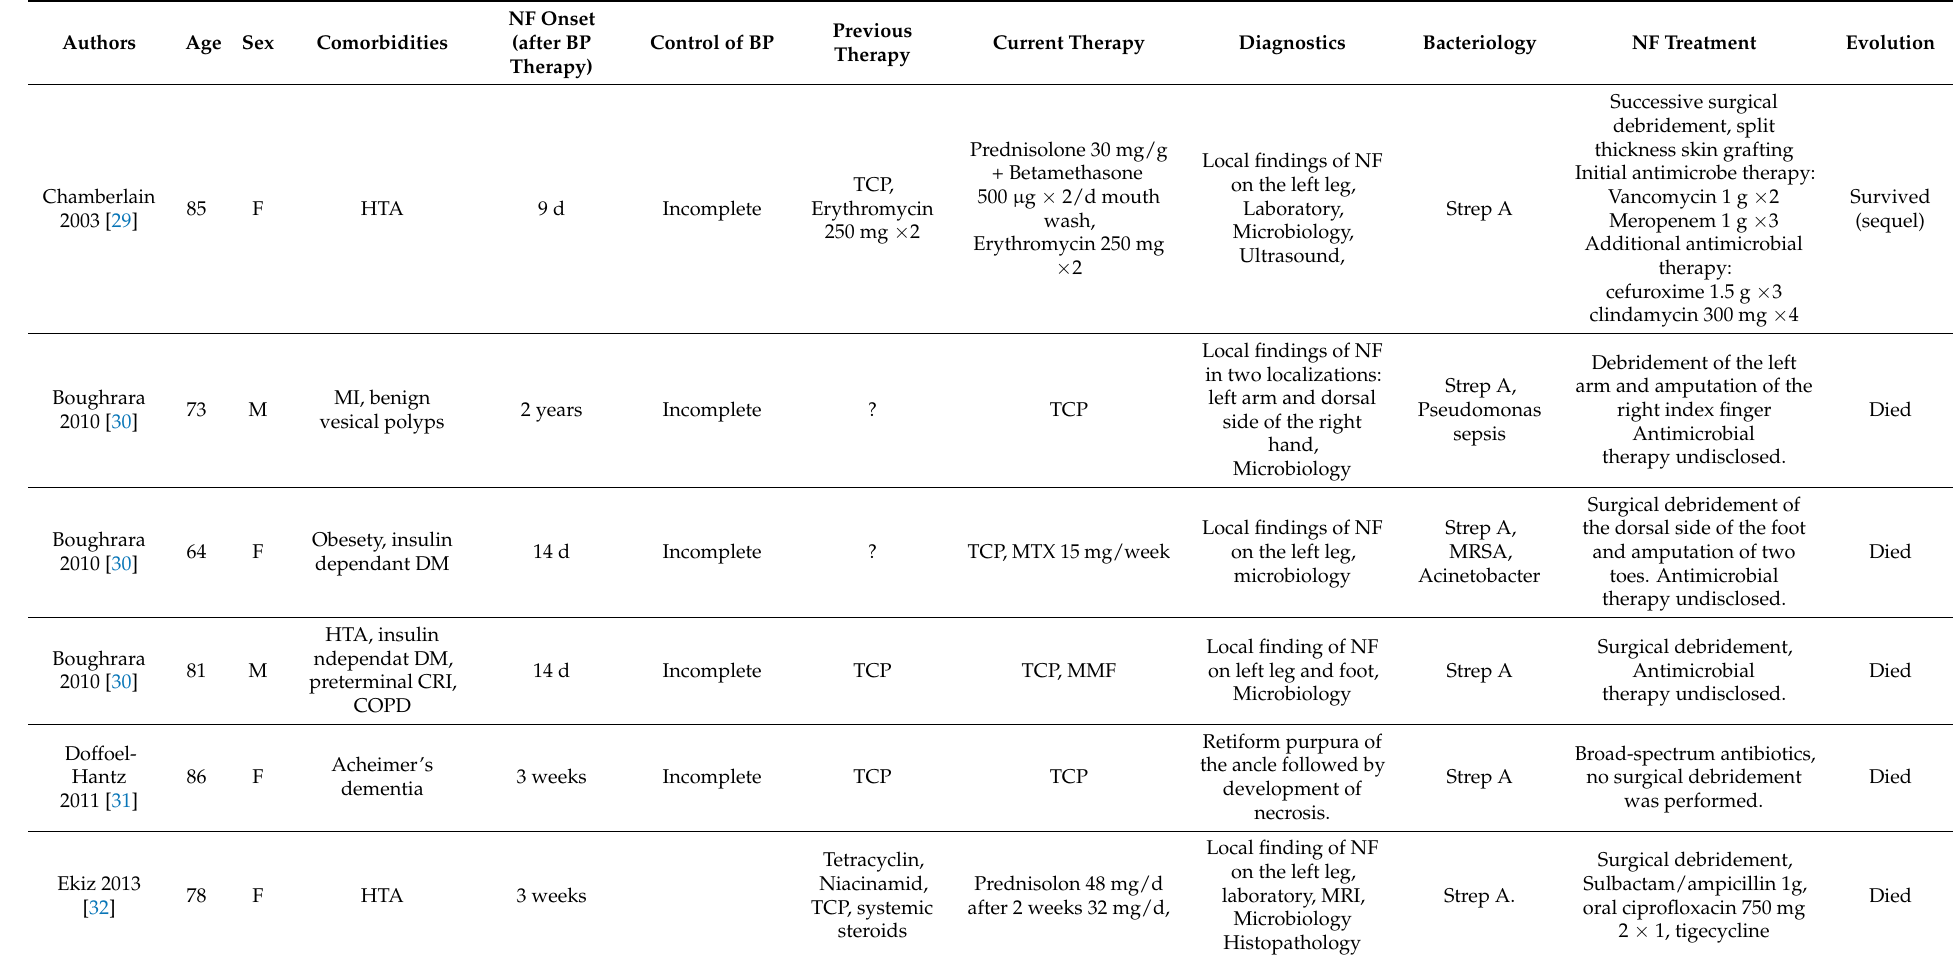
Table 1. A systematic review of all case reports included by the JBI Manual for Evidence Synthesis